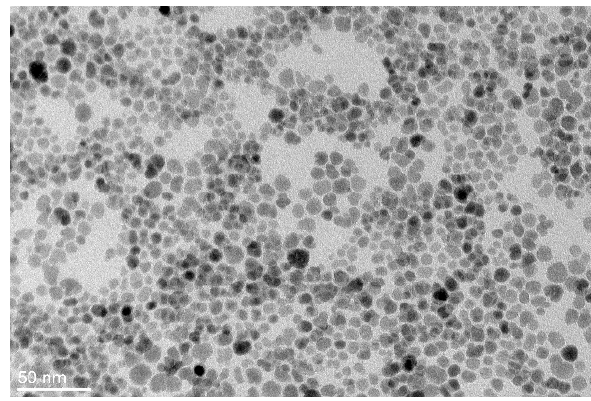
Figure 1. TEM image of maghemite nanoparticles in a magnetic fluid sample.